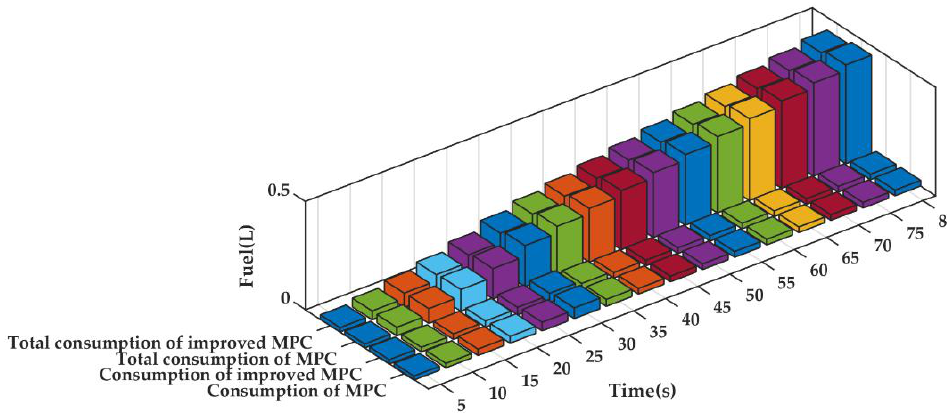
Figure 15. The fuel consumption in Scenario 1.